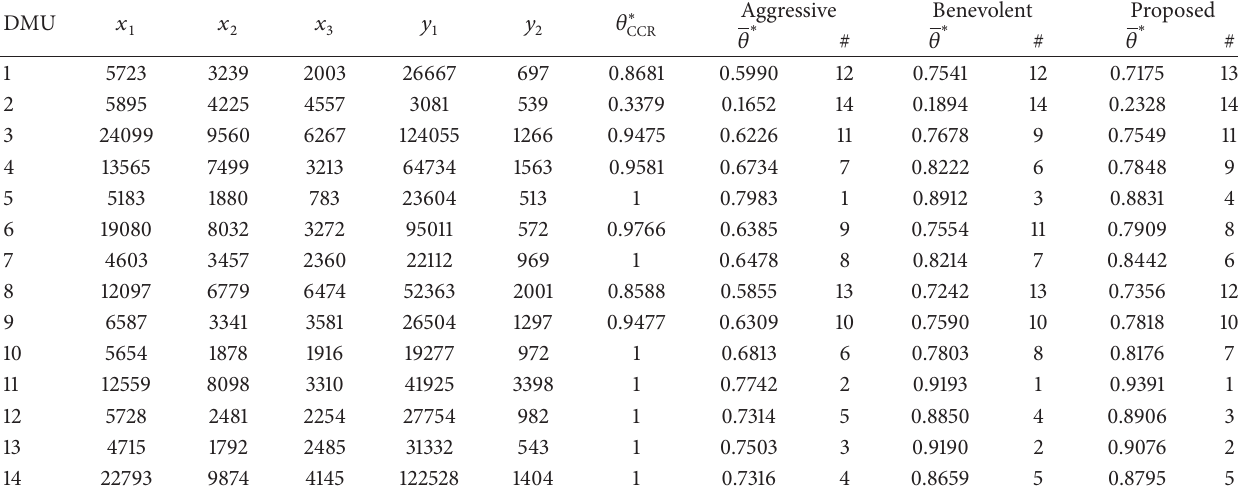
Table 2: Data, efficiency scores, and ranks for 14 passenger airlines using different cross-efficiency models.